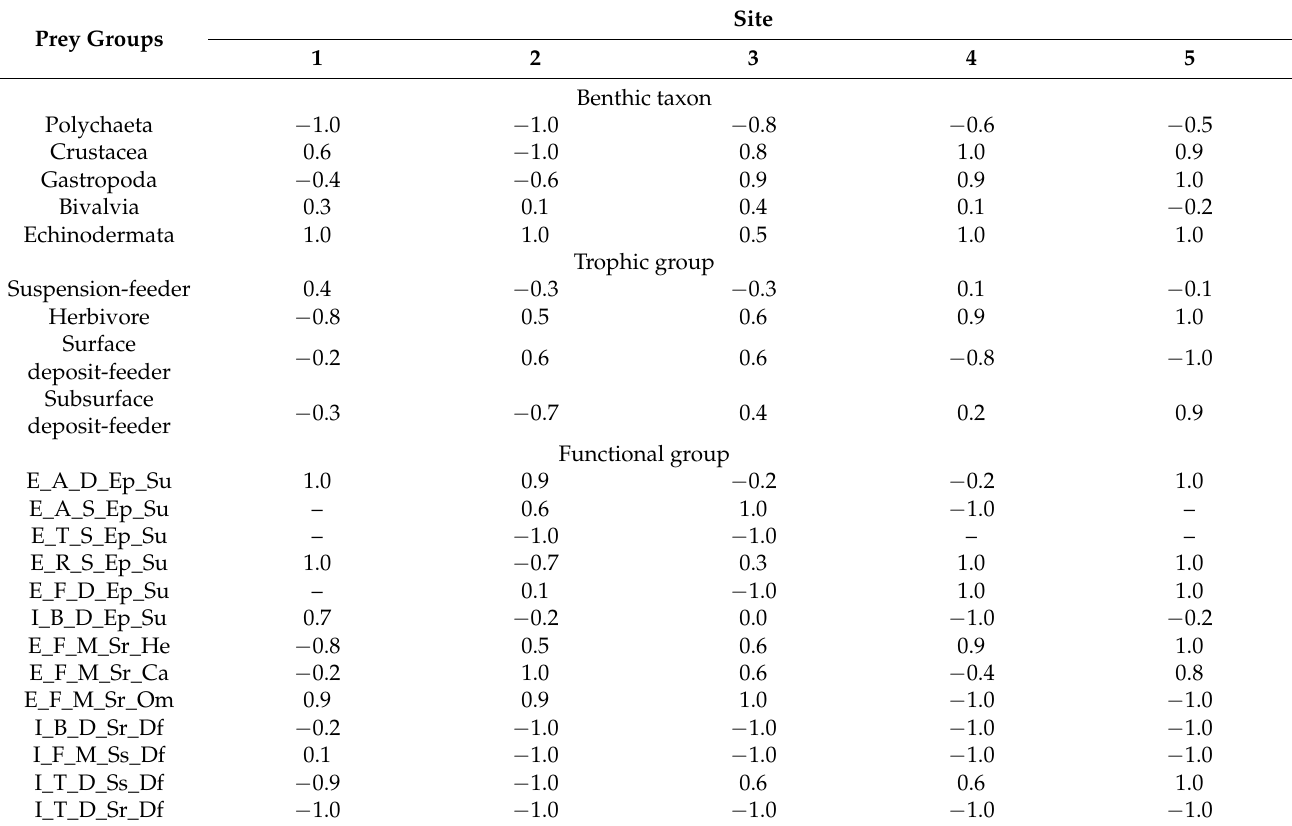
Table 4. Ivlev’s electivity (E) for major taxa, trophic groups, and functional groups of benthic food items of red king crabs in Kola